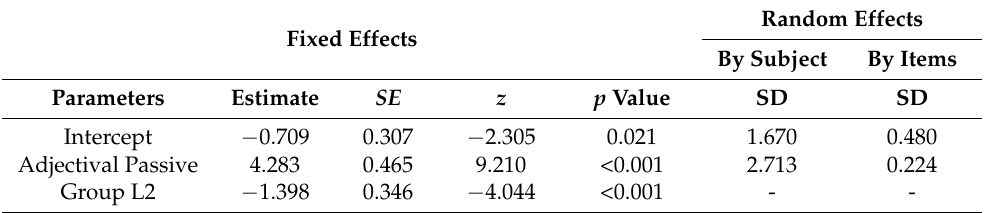
Table 7. Parameter estimates for L2 and HL learners’ comprehension of adjectival and verbal passives.